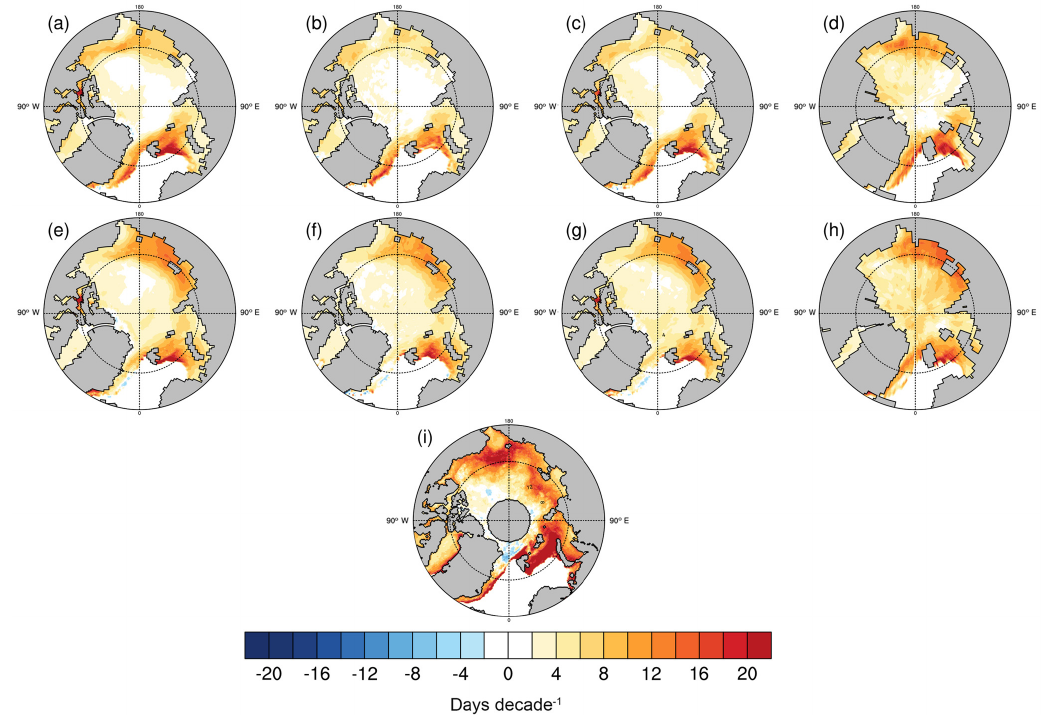
Figure 8. Trends in freeze onset dates over 1979–2014 for each CESM LE definition in the two members where they are available (member 34 in a–d , member 35 in e–h ) as well as in the PMW satellite observations (i) . The congelation ice growth definition is shown in (a) and (e) , the frazil ice growth definition is shown in (b) and (f) , the thermodynamic ice volume tendency definition is shown in (c) and (g) and the surface temperature definition is shown in (d) and (h)